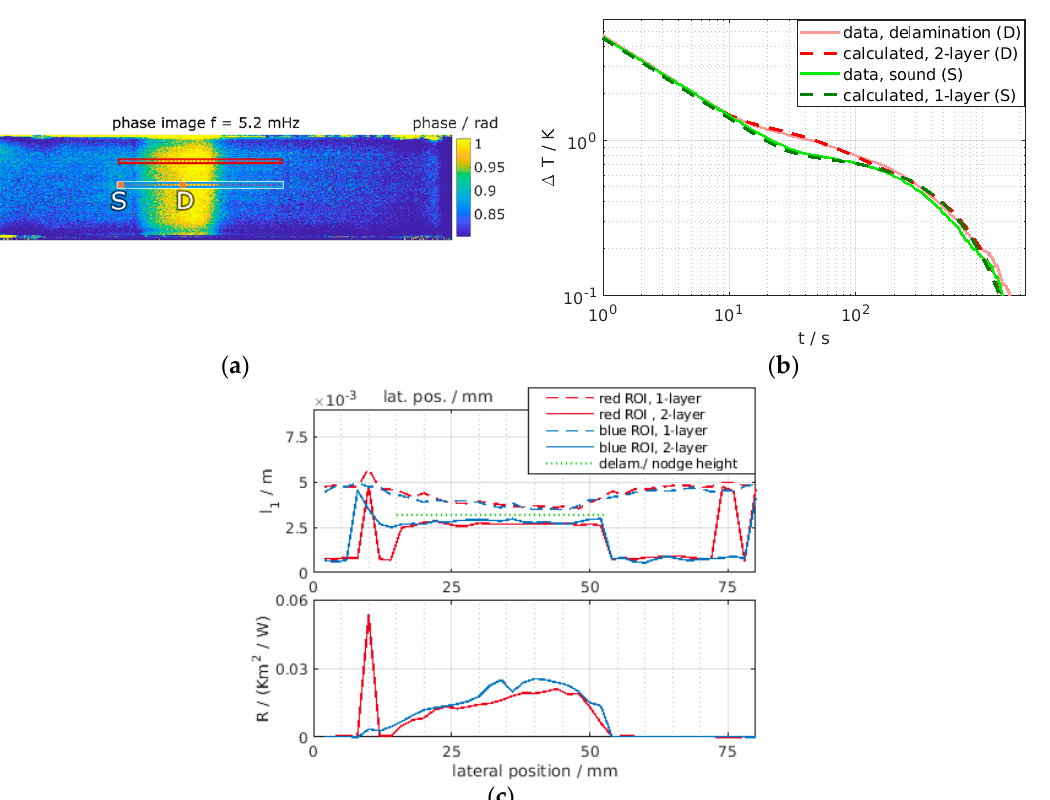
Figure 2. ( a ) Phase image of the sample, the lines of ROI investigated are marked. ( b ) Measured transient in ROI and fitted signal for a sound area (S) and over the delamination (D), locations marked in ( a ). ( c ) Parameters 𝑙 (cid:2869) and 𝑅 at two lines on the specimen, for the one layer and two-layer model. A green dotted line depicts the estimated depth of the